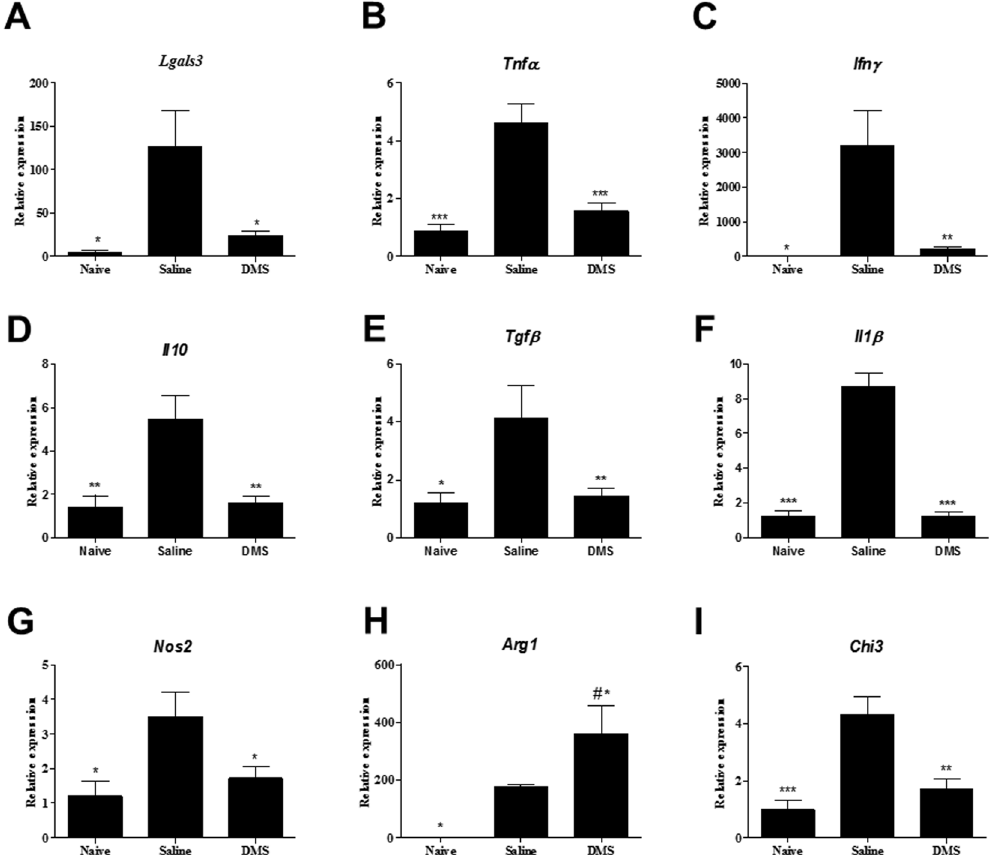
Figure 3. Gene expression in the hearts of infected mice after DMS treatment. Analysis of gene expression was performed by real-time qRT-PCR using cDNA samples prepared from mRNA extracted from hearts of naive and chronic Chagasic mice treated with saline or DMS. ( A ) Gal-3, ( B ) TNF α , ( C ) IFN γ , ( D ) IL-10, ( E ) TGF β , ( F ) IL-1 β , ( G ) NOS2, ( H ) ARG1 and ( I ) CHI3 gene expression. Bars represent means ± SEM of 10 mice/group. *** P < 0.001; ** P < 0.01; * P < 0.05 compared to saline group; # P < 0.05 compared to naive